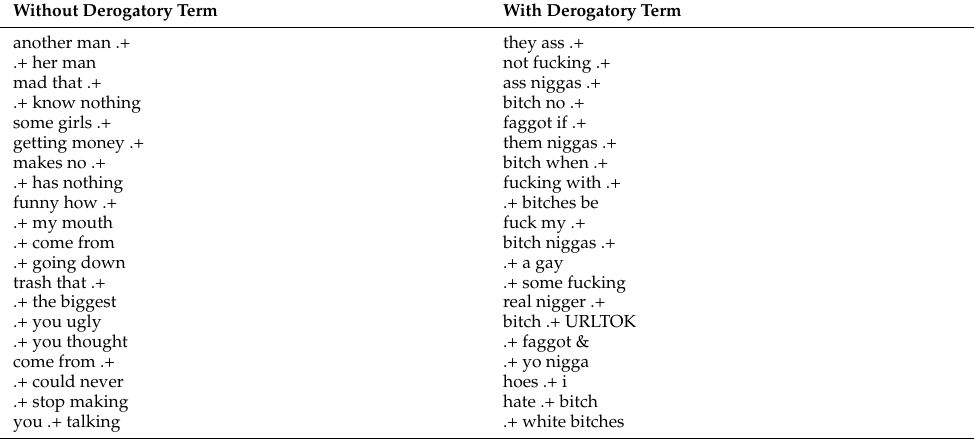
Table 8. Top 20 common patterns that were generated in all the datasets. “.+” represents the wildcard